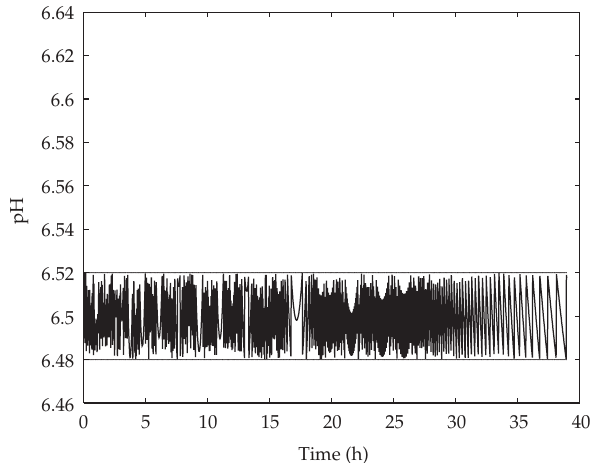
Figure 9: Simulation of the pH during 30–33 hours of fed-batch